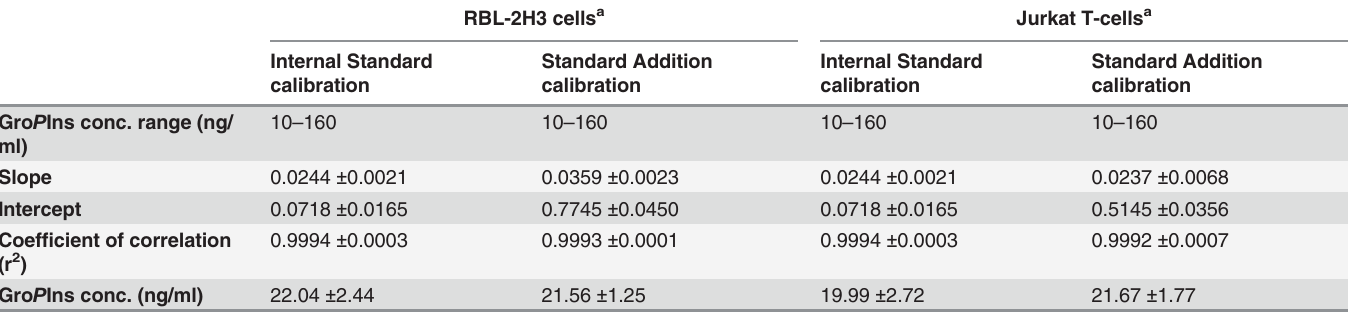
Table 3. Linearity and Gro P Ins concentration in RBL-2H3 and Jurkat T-cell extracts by internal standard calibration and standard addition method.